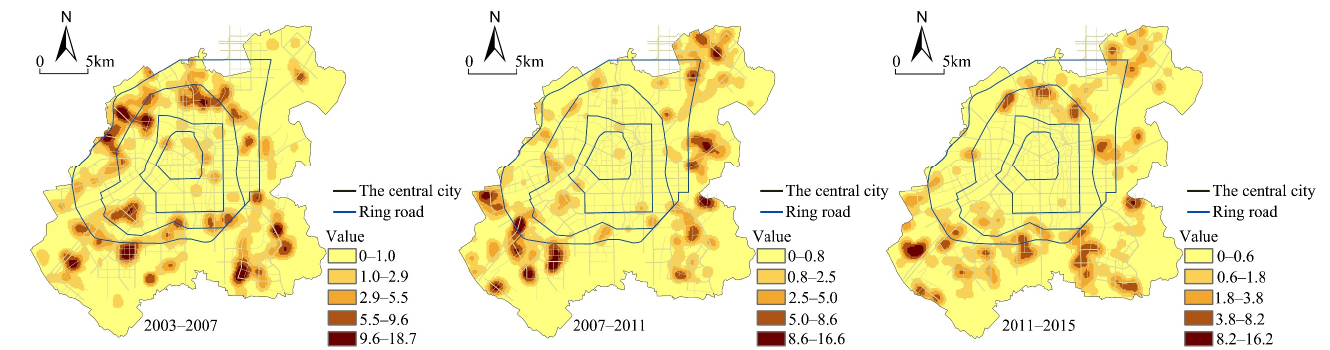
Figure 4. Overall characteristics of the kernel density of the functional urban land expansion. This figure is the kernel density map of the total expanding area of the four types of functional urban land, so the kernel density value is greater than that of a certain type of functional urban land. Table 1. Transition matrix of functional urban land replacement from 2003 to 2015. Unit: ha.